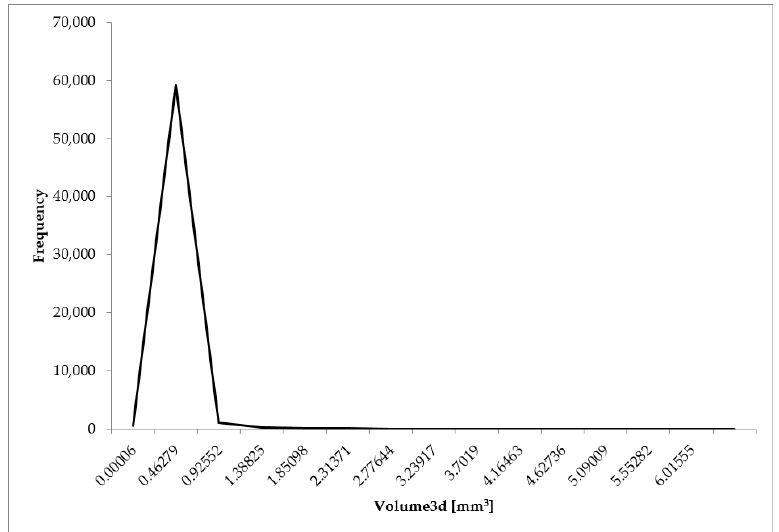
Figure 10. Distribution of 3D volume of the analyzed porous biomaterial samples. The minimum equivalent diameter for all the samples was 48 μ m. The mean equivalent diameter ranged from 395 (sample 1) to 427 μ m (sample 2). The mean value of the parameter was 411 μ m. The maximum equivalent diameter ranged from 2074 for sample 2 to 2256 μ m for sample 3. The mean value of the parameter was 2162 μ m. The minimum 3D area of a single pore for all the samples was 6941 μ m 2 . The mean 3D area ranged from 689,581 (sample 1) to 920,971 μ m 2 (sample 3). The mean value of the parameter was 787,599 μ m 2 . The maximum 3D area ranged from 14,978,800 (sample 2) to 19,217,900 μ m 2 (sample 1). The mean value of the parameter for the samples was 17,235,567 μ m 2 . The minimum volume was 0.00006 mm 3 for all the samples. The mean volume ranged from 0.05901 (sample 1) to 0.12328 mm 3 (sample 3). It follows that the value of the mean pore volume for sample 3 is more than twice as high as that for sample 1. The mean value of the parameter was 0.08446 mm 3 . The maximum pore volume ranged from 4.67266 for sample 2 to 6.01555 mm 3 for sample 3. The mean value of the parameter was 5.31223 mm 3 . The lowest value of the total pore volume was 1442 mm 3 for sample 2. Sample 1 (1706 mm 3 ) was characterized by the highest value. The mean value of the parameter for the samples was 1552 mm 3 . The sample porosities are similar. The highest value of porosity was 36% (sample 1) and the lowest 30% (sample 2). The mean porosity was 32%. Samples differ in porosity because, during the manufacturing process, the repeatability of manual mixing and pouring of the slurry into the molds is not ideal. The resulting porous structure is also influenced by the external conditions of the manufacturing process, including the ambient temperature and humidity during molding. The results obtained during the image analysis indicate the slight geometrical variation of the samples. However, sample 1 has the highest porosity and total pore volume. It is also characterized by the smallest mean diameter, mean 3D area, and mean volume. Moreover, the pores of sample 1 have the largest maximum 3D area of all the test samples. Sample 2, on the other hand, is characterized by the lowest porosity and total pore volume, as well as the highest mean diameter and pore volume. Moreover, sample 2 has the smallest values of the maximum diameter, maximum 3D area, and maximum pore volume.